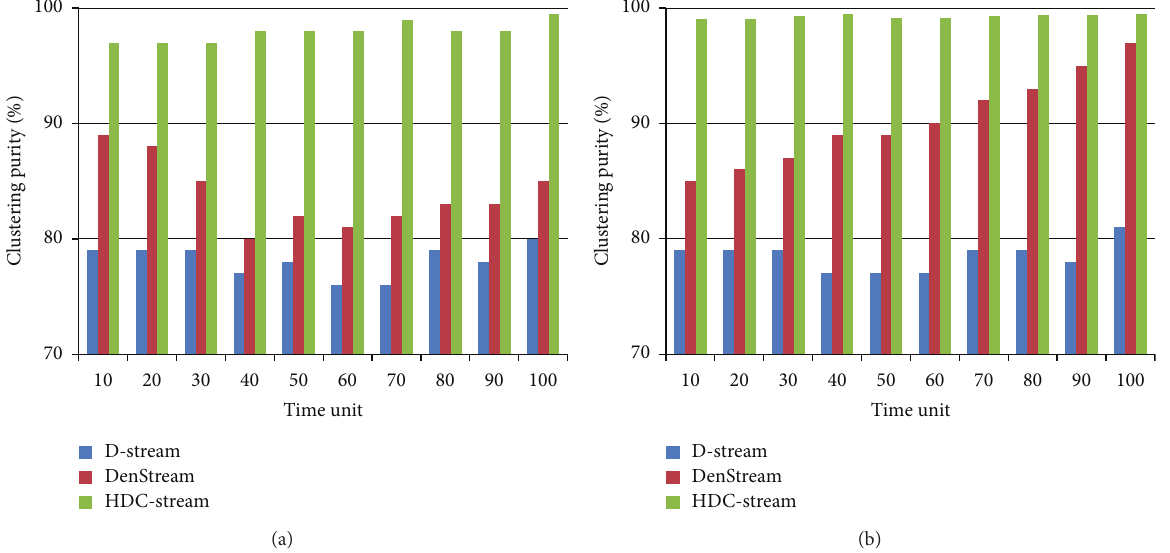
Figure 5: Cluster purity of HDC-Stream for EDS with (a) horizon = 1 and stream speed = 2000 and (b) horizon = 5 and stream speed =